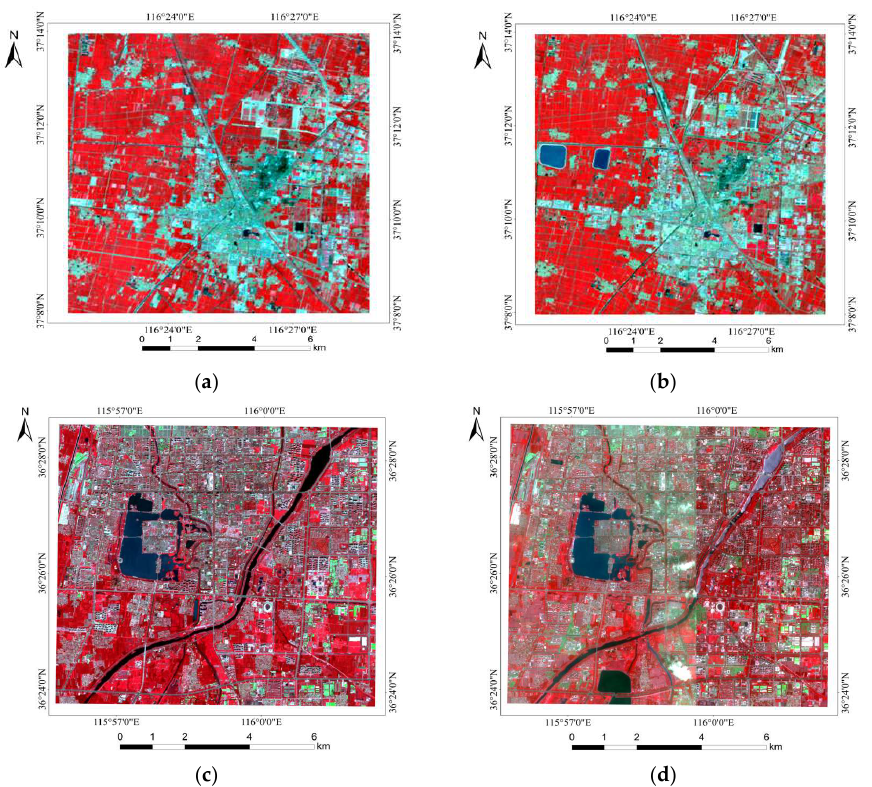
Figure 7. ( a ) The Landsat 8 image acquired in 2013 in Dezhou City, Shandong Province, China. ( b ) The Landsat 8 image acquired in 2018 in Dezhou City, Shandong Province, China. ( c ) The Sentinel-2 image acquired in 2016 in Liaocheng City, Shandong Province, China. ( d ) The Sentinel-2 image acquired in 2021 in Liaocheng City, Shandong Province, Table 2. A description of user demand and information on images from different study areas.